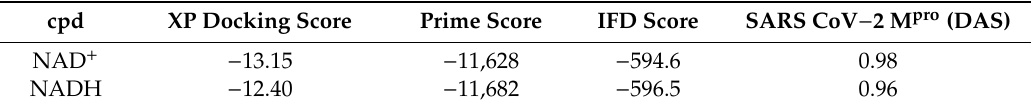
Table 6. DRUDIT and IFD output results for NAD + and